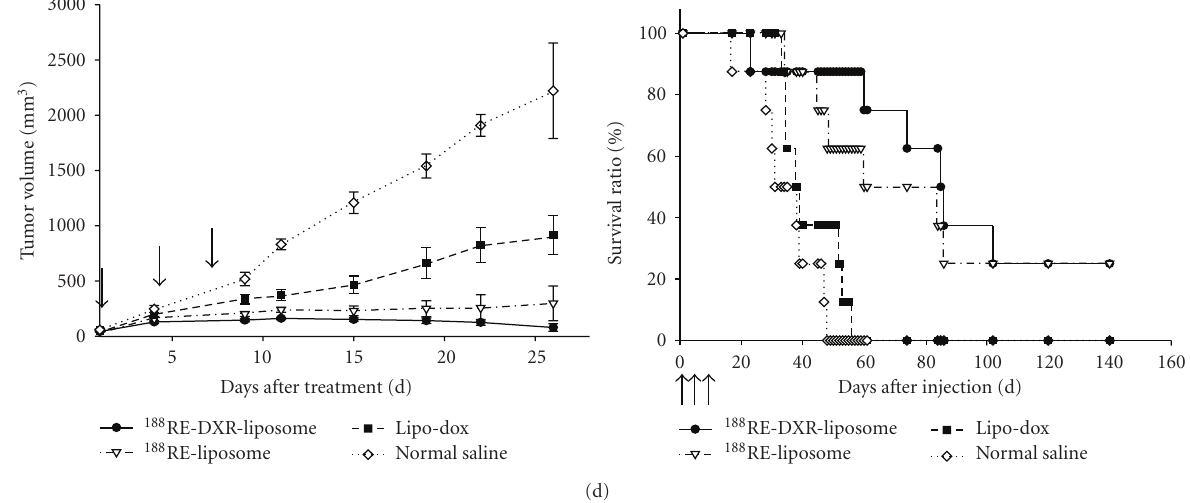
Figure 2: (a) Gamma scintigraphy of BALB/c mice bearing CT-26 tumor animal model at 24 hr and 48 hr after intravenous injection of passively nanotargeted radionuclides of 111 In-DTPA-liposome (reprinted with permission from reference [70]). (b) Tumor growth inhibition with passively nanotargeted radionuclides of 111 In-(VNB)-liposome on HT-29/luc tumor bearing in SCID mice animal model (reprinted with permission from reference [71]). (c) MicroSPECT/CT images of passively nanotargeted radionuclides of 188 Re-liposome and 188 Re- DXR-liposome targeting CT-26 bearing in BALB/c mice animal model at 1h, 4h, 24 h, and compare with the control (reprinted with permission from reference [72]). (d) Therapeutic e ffi cacy of tumor volume change and survival ratio for CT-26 tumor-bearing BALB/c mice after intravenous administration of passively nanotargeted radionuclides of 188 Re-(DXR)-liposome were illustrated. (reprinted with permission from reference